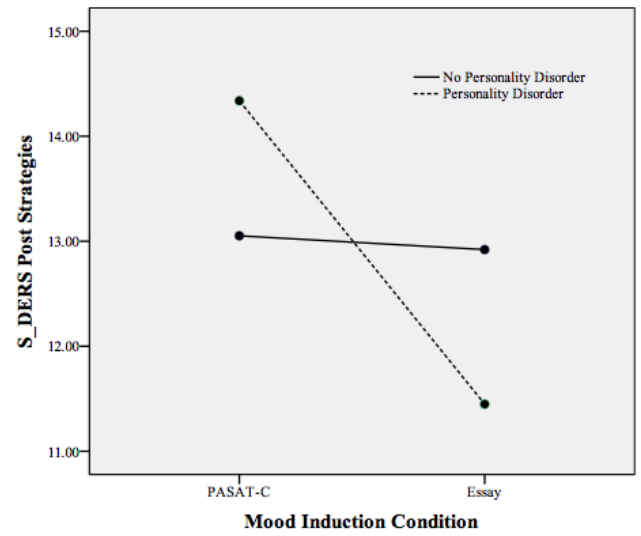
Figure 1. Plot of the statistically significant interaction between mood induction condition and personality disorder on the S-DERS subscale of state difficulties in emotion regulation strategies following both mood inductions. Higher scores indicate more difficulties in emotion regulation